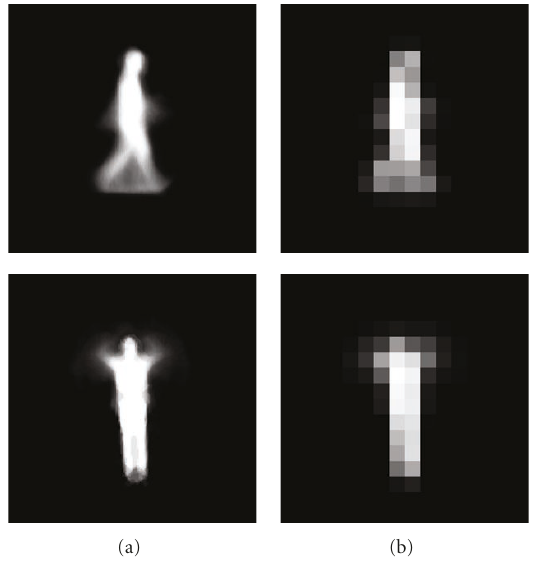
Figure 3: MEHs of two periodic motions (a) and their corresponding low-resolution image